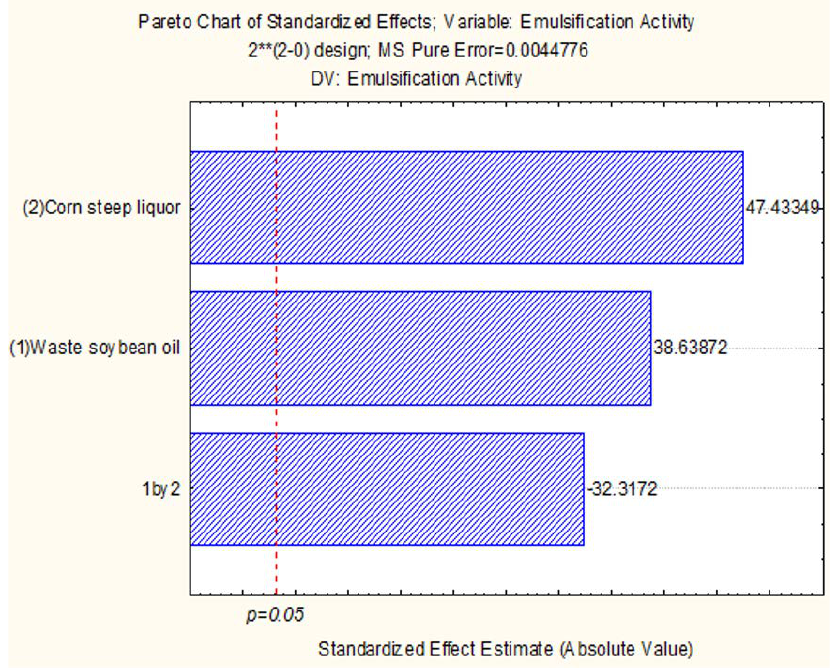
Figure 1. Pareto chart for 2 2 factorial design of culture after 96 h, where (1) corn steep liquor and (2) waste soybean oil are the independent variables and emulsifying activity is the response variable. The point at which the effect estimates were statistically significant is